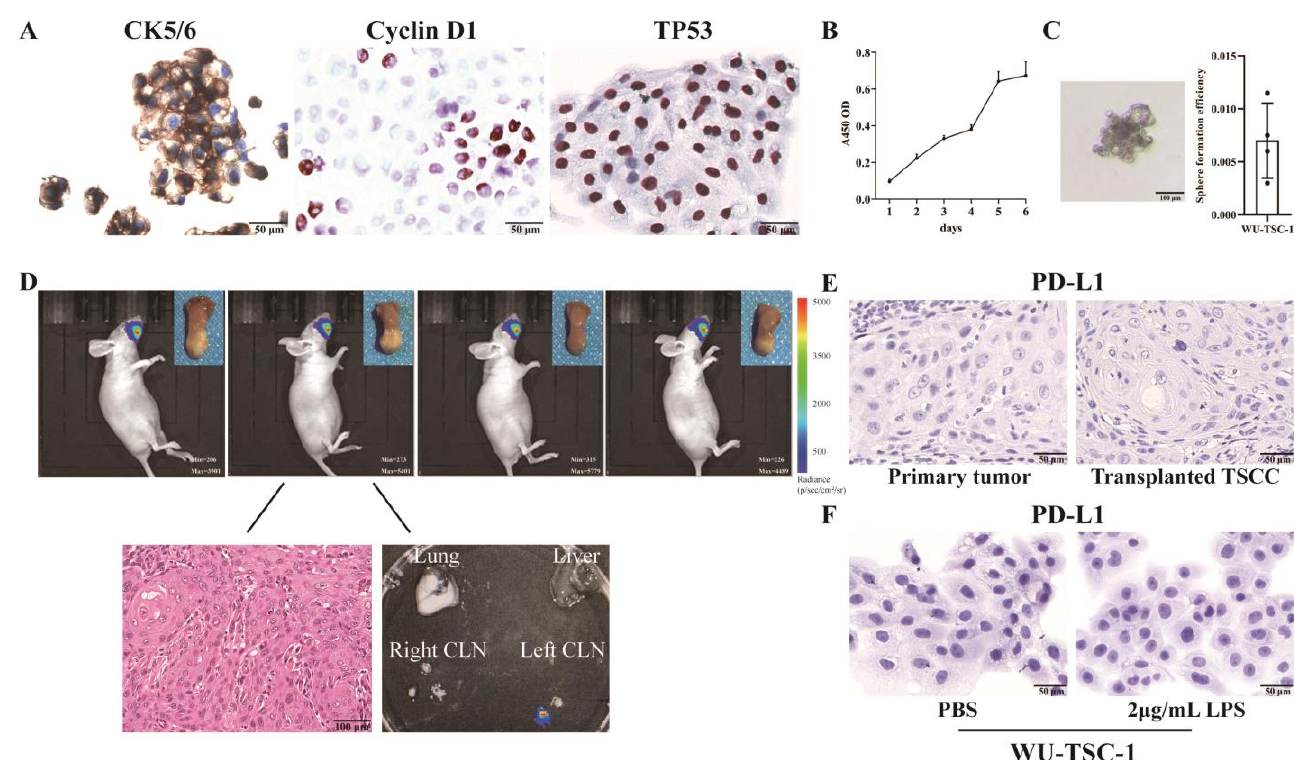
Figure 2. Neoplastic characteristics of WU-TSC-1 cell line: ( A ) The immunocytochemical staining of CK 5/6, Cyclin D1 and TP53 in WU-TSC-1 (400×). ( B ) Growth curve of WU-TSC-1. ( C ) Spheroid formation of WU-TSC-1 (200×). ( D ) Orthotopic tumor grafting in the lateral tongue of the nude mice (upper). The radioactive signals obtained from tumor cells are encoded in color scale: from black (no signal) to violet, blue, green, yellow, orange, red (high intensity signal) and white (saturated signal). Higher color intensity represents more tumor cell density. Metastatic tumor cells were observed in ipsilateral cervical lymph nodes (200×). ( E ) Negative expression of PD-L1 in primary tumor and transplanted tongue SCC (400×). ( F ) Negative expression of PD-L1 in WU-TSC-1 cells after stimulation with LPS (400×).